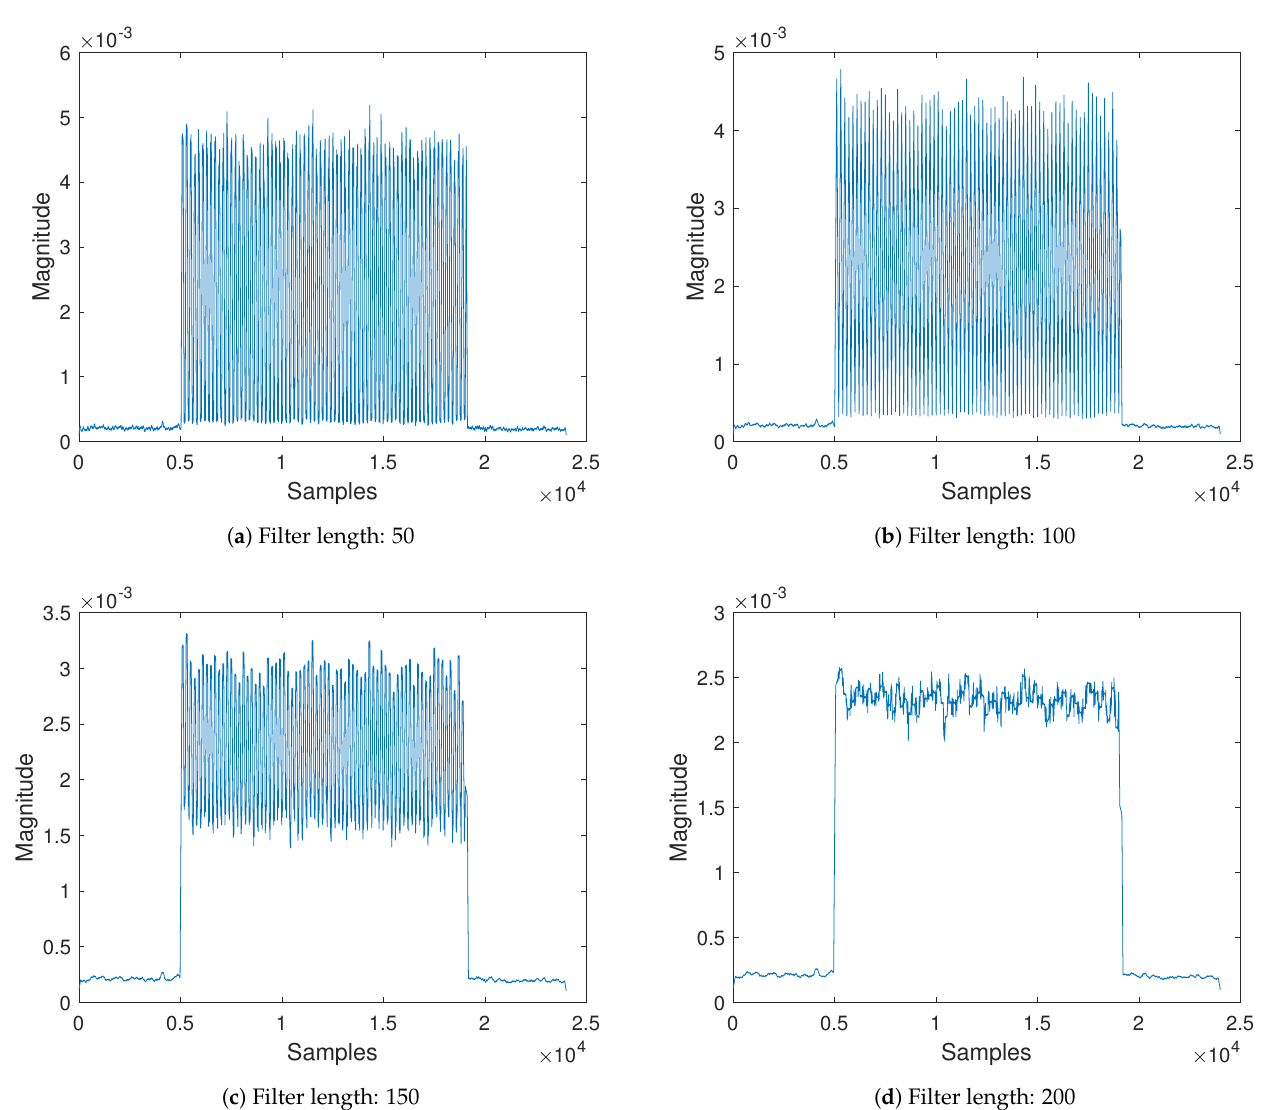
Figure 4. Moving average filter response with increased filter